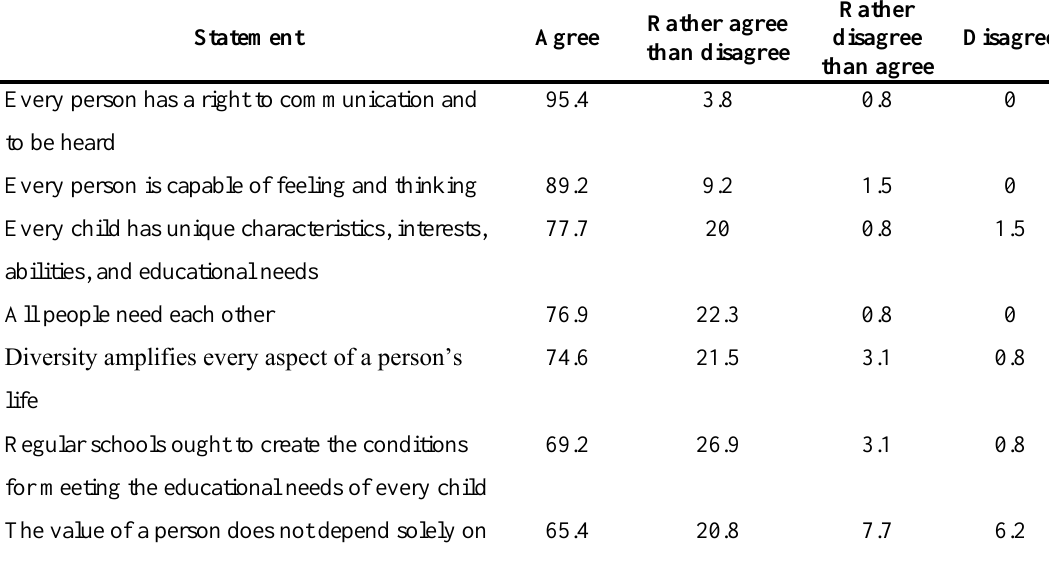
Table 3. Degree of Teacher Acceptance of the Values of Inclusive